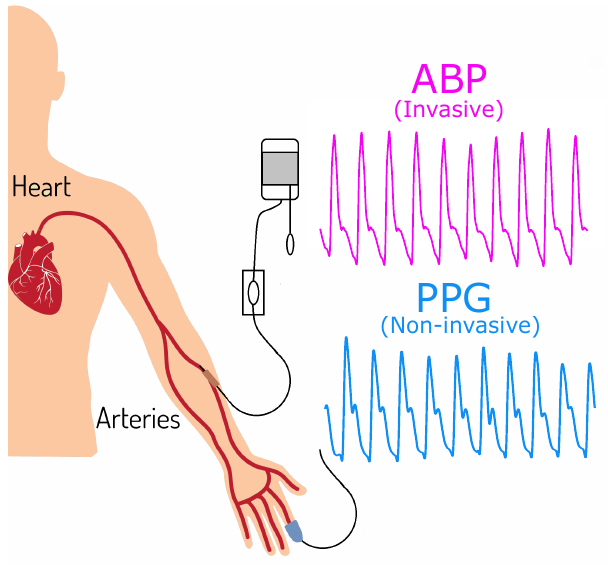
Figure 1. Simultaneously collected Arterial Blood Pressure (ABP) and Photoplethysmogram (PPG) signals. Note, ABP was measured invasively while PPG was measured